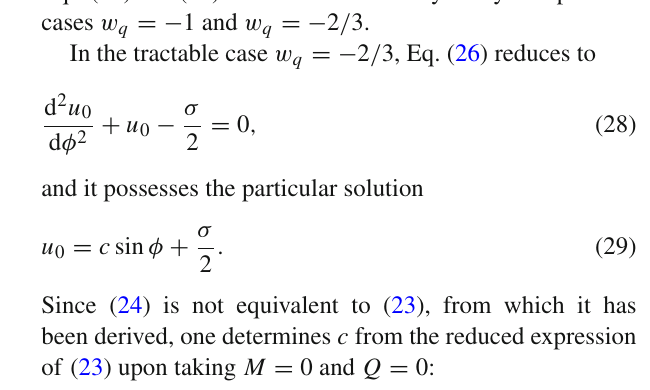
(with − 1 ≤ w q < − 1 / 3) as if M = 0 and Q = 0,